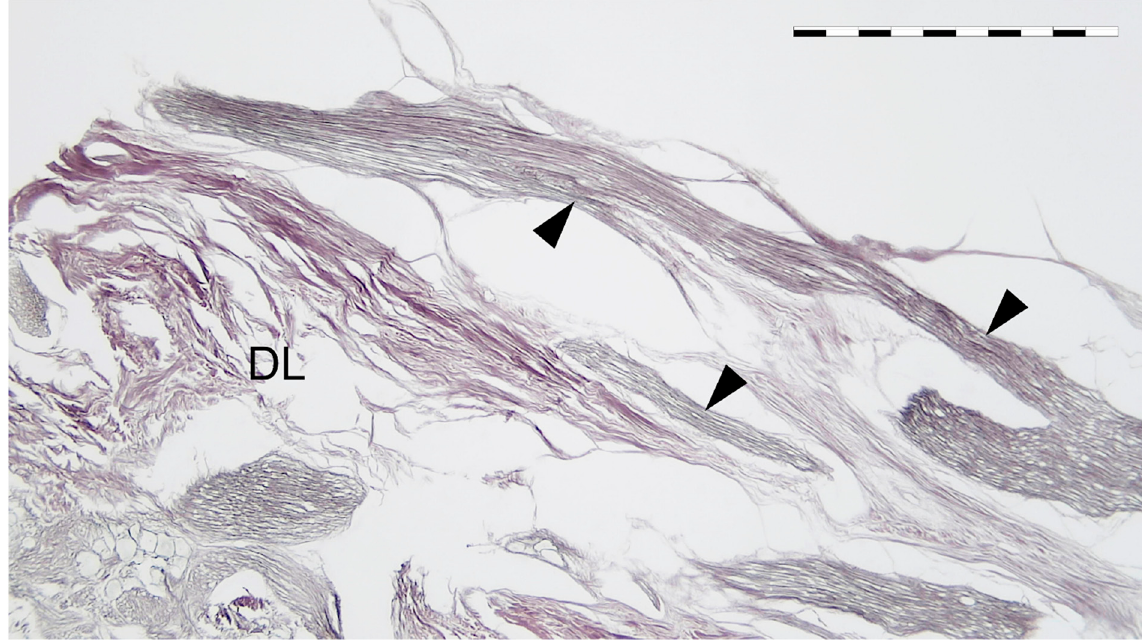
Figure 6. Communications between the ICP and the lateral wall of the CS (black arrowheads). Silver staining according to Gordon and Sweet’s method. 4 × objective. DL—deep layer (reticular membrane) of the lateral wall of the CS. Scale bar corresponds to 1 mm.